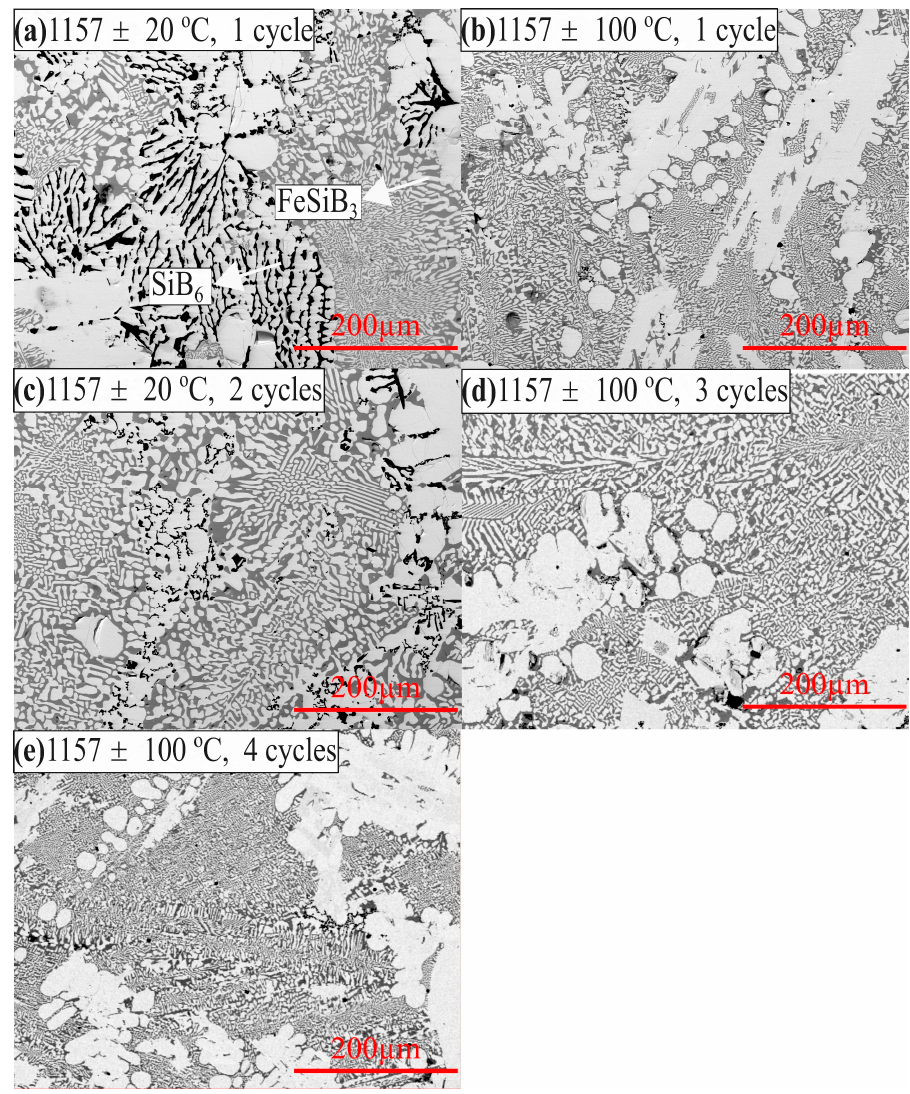
Figure 14. Backscattered electron images at different thermal cycles in the center position of the samples. ( a ) 1 cycle at 1157 ± 20 °C, ( b ) 1 cycle at 1157 ± 100 °C, ( c ) 2 cycles at 1157 ± 20 °C, ( d ) 3 cycles at 1157 ± 100 °C, ( d ) 4 cycles at 1157 ± 100 °C.